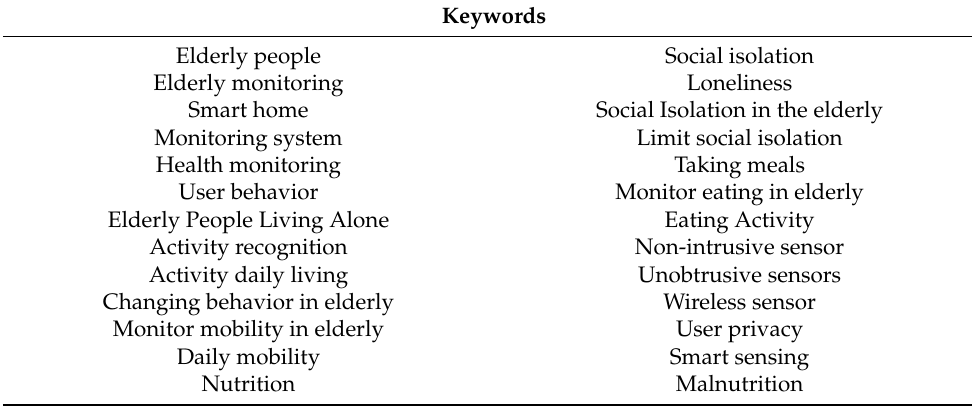
Table 1. Keywords used for the literature search.